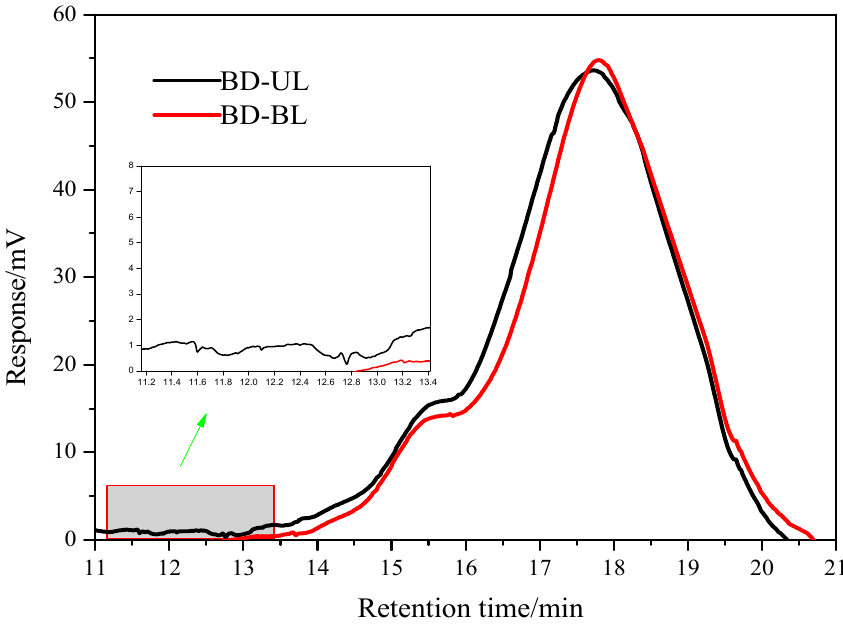
Figure 3. GPC curves of bitumen from BD-UL and BD-BL. 132